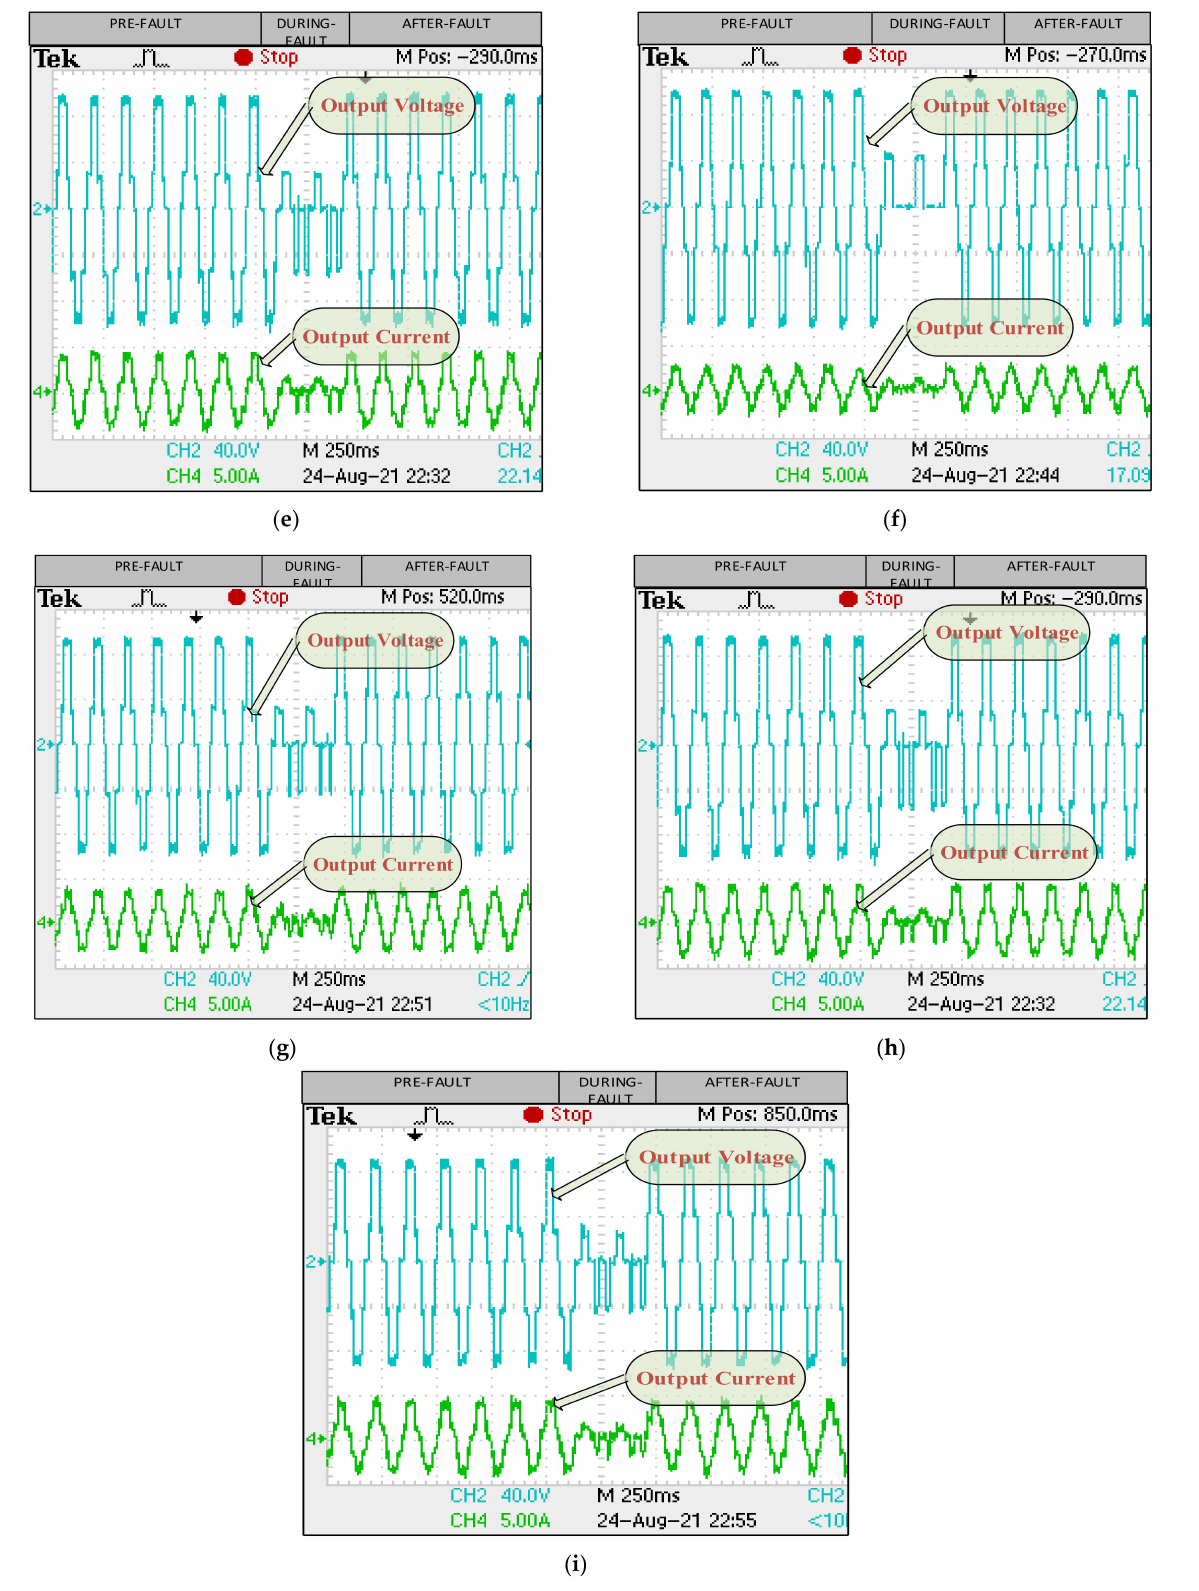
Figure 12. ( a ) Fault in switch S 1, ( b ) fault in switch S 2, ( c ) fault in switch S 3, ( d ) fault in switch S 4, ( e ) fault in switch S 5, ( f ) fault in switch S 6, ( g ) fault in switch S 7, ( h ) fault in switch S 8, and ( i ) fault in switch S 9